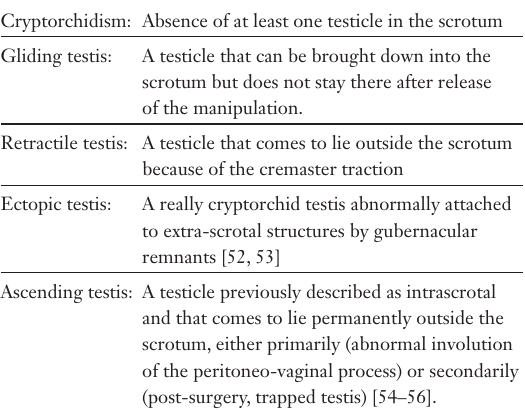
Definitions of terms used to characterise cryptorchidism Cryptorchidism: Absence of at least one testicle in the